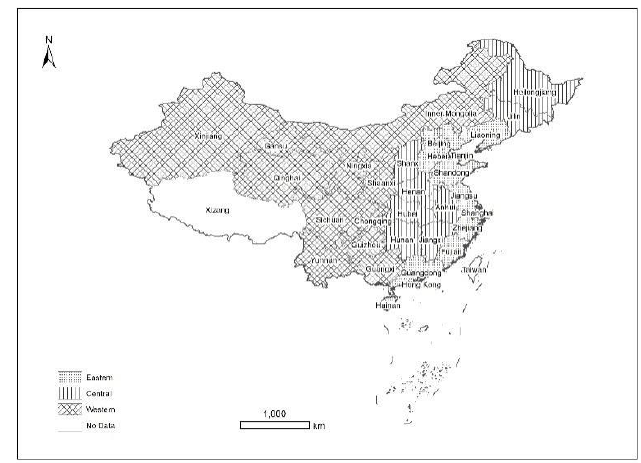
Figure 1. Schematic diagram of the three regions of China.